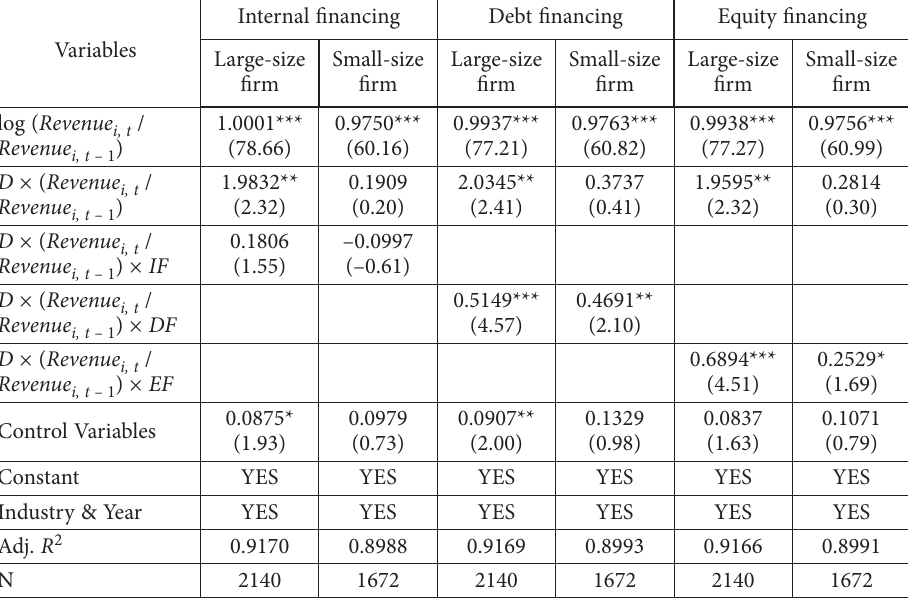
Table 5. Regression results of financing constraints, firm size and cost stickiness